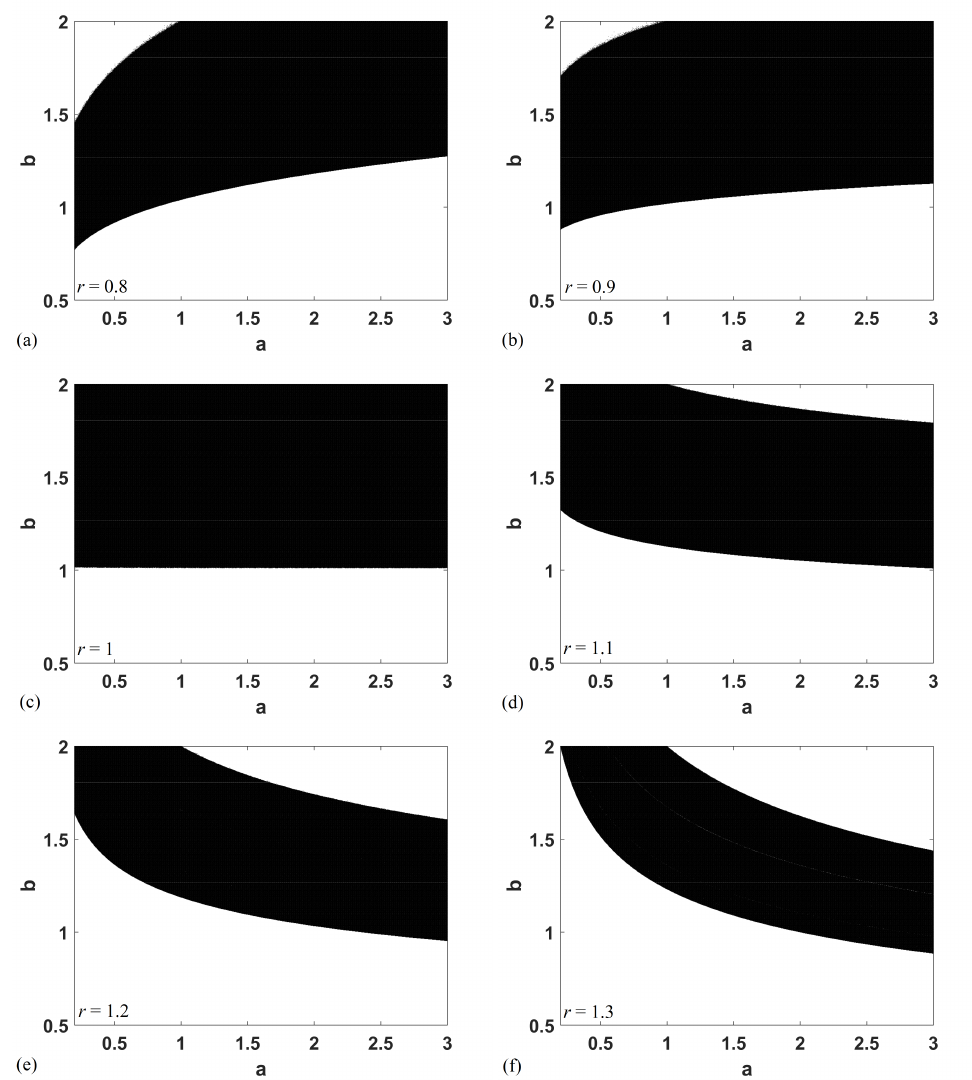
Figure 10. Two-dimensional LE diagram for the considered map, for: ( a ) r = 0.8; ( b ) r = 0.9; ( c ) r = 1; ( d ) r = 1.1; ( e ) r = 1.2; ( f ) r =